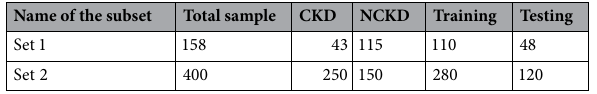
Table 2. Sample sizes for training and testing set.